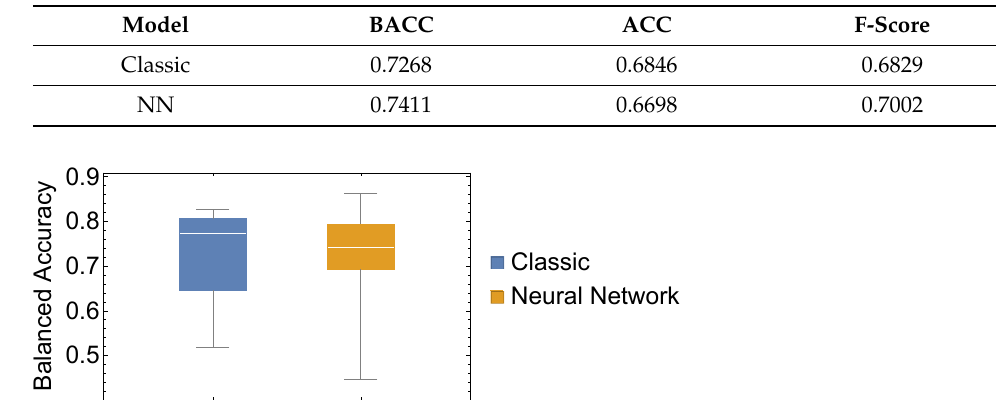
Figure 5. Experiment I: Box whisker chart of BACC values of our 15 datasets for both consid- ered methods.